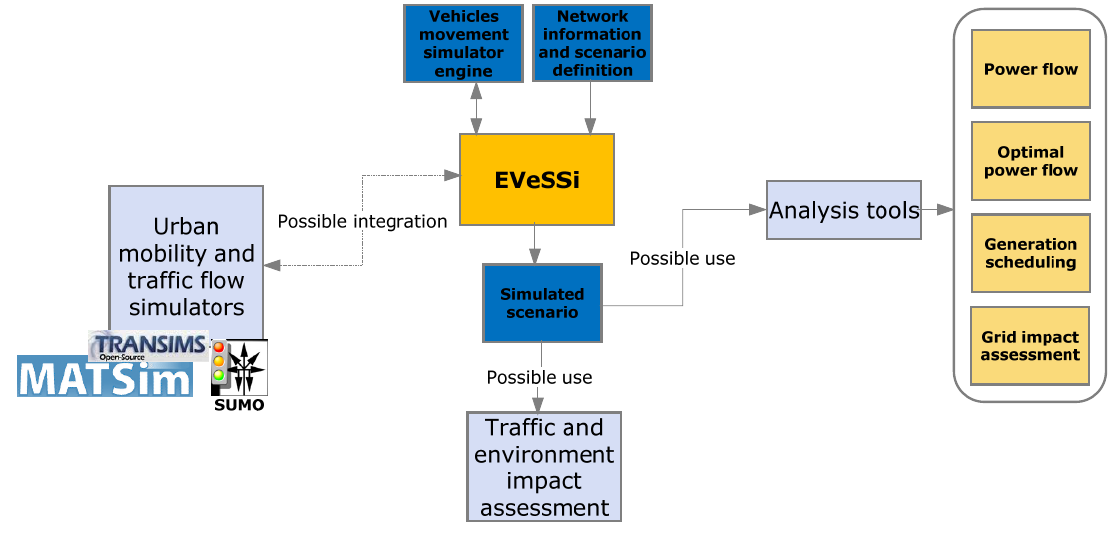
Figure 1. Electric Vehicle Scenario Simulator (EVeSSi) application